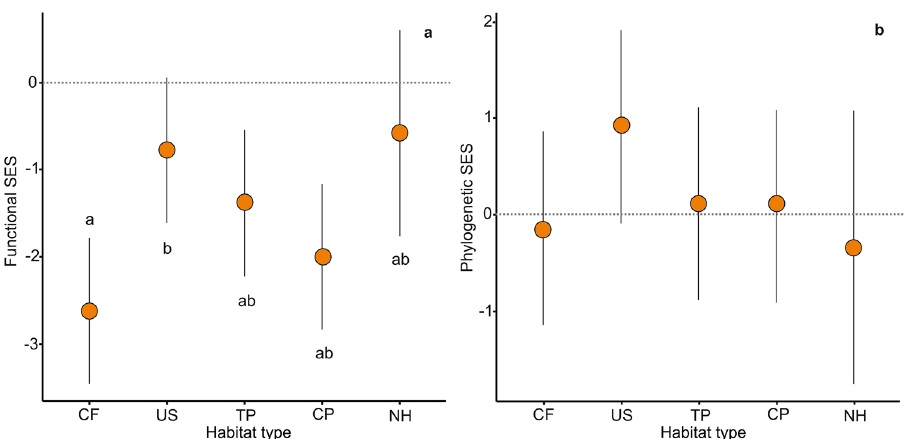
Figure 2. Differences in functional ( a ) and phylogenetic ( b ) SES among habitat types ( CF crop fields, US urban settlements, TP tree plantations, CP cattle pastures, NH natural habitats) in the Grassland. Circles are means and bars are equivalent to confidence intervals of 95%. Different letters indicate significant differences ( P < 0.05) between pairs of habitat types: results of Tukey multiple comparisons of means through emmeans function of functional and phylogenetic SES between habitat